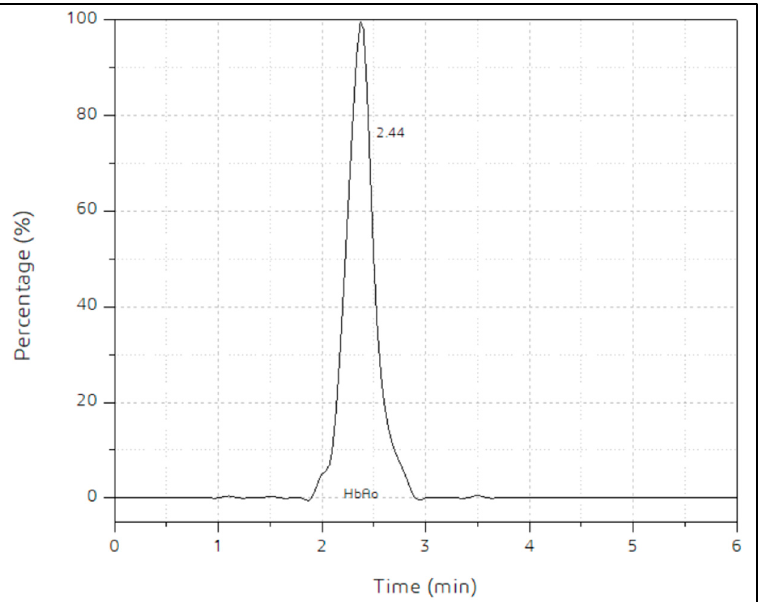
Figure A8. Chromatogram of cation exchange chromatography of pure hemoglobin solution, the hemoglobin from conjugates of impure Hb and MNPs, and hemoglobin from conjugates of purified Hb and MNPs.